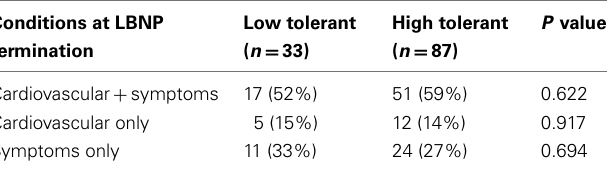
Table 2 | Prevalence of presyncopal conditions at LBNP termination in low tolerant and high tolerant